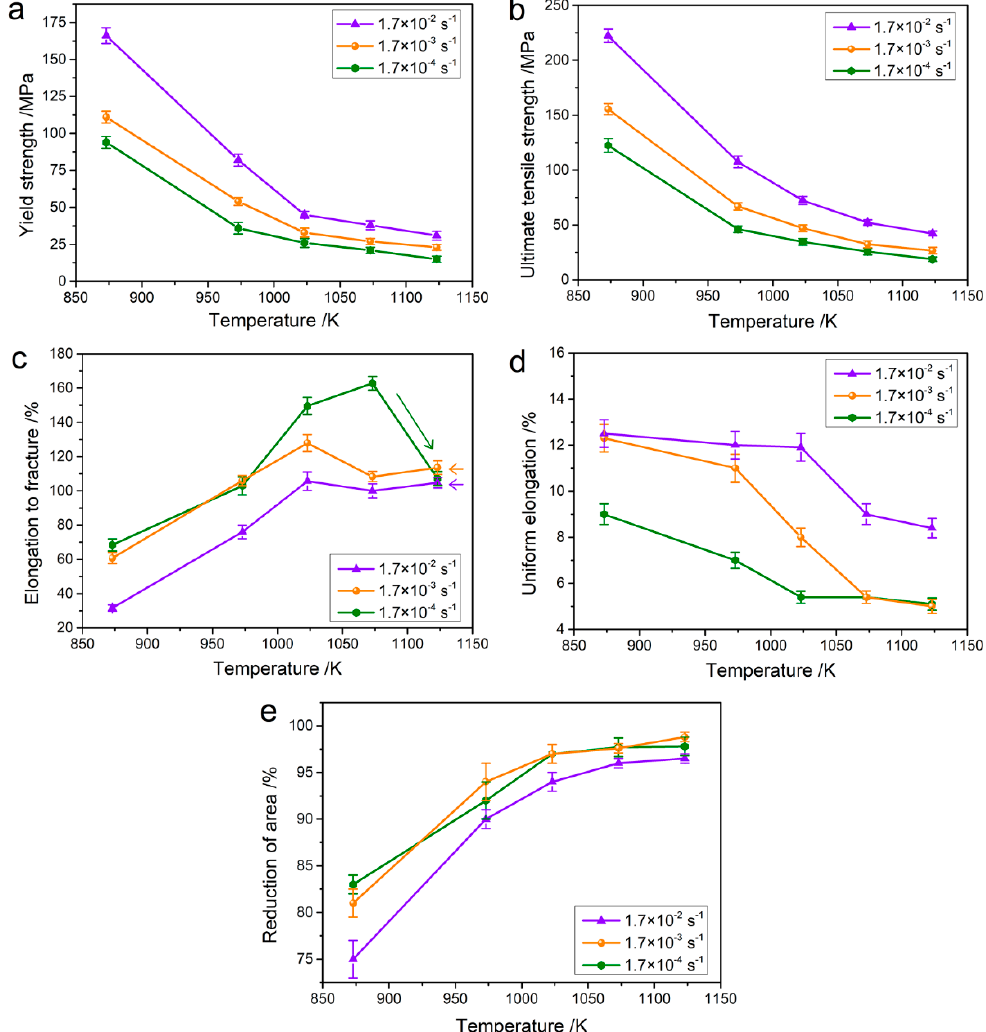
Figure 3. Tensile properties of the 0Cr18AlSi steel tested at different conditions: ( a ) yield strength, YS; ( b ) ultimate tensile strength (UTS); ( c ) elongation to fracture (EL); ( d ) uniform elongation (UE); ( e ) reduction of area (RA).